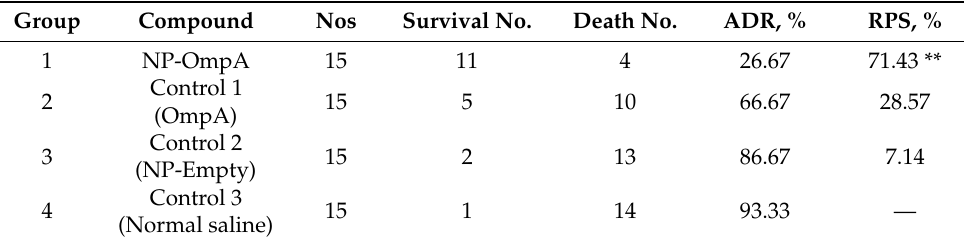
Figure 9. After challenge with E. coli . Table 3. Active immune protection observed in